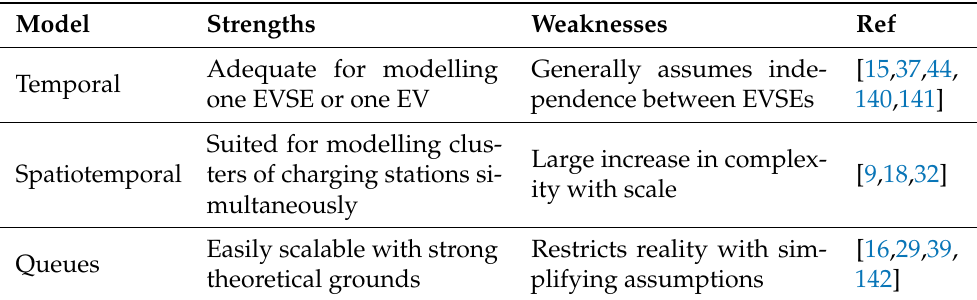
Table 3. Stochastic processes for EV